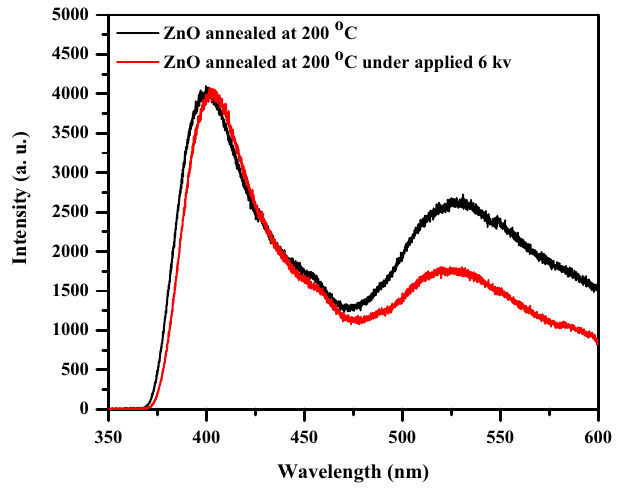
Figure 5. PL spectra of ZnO thin films.